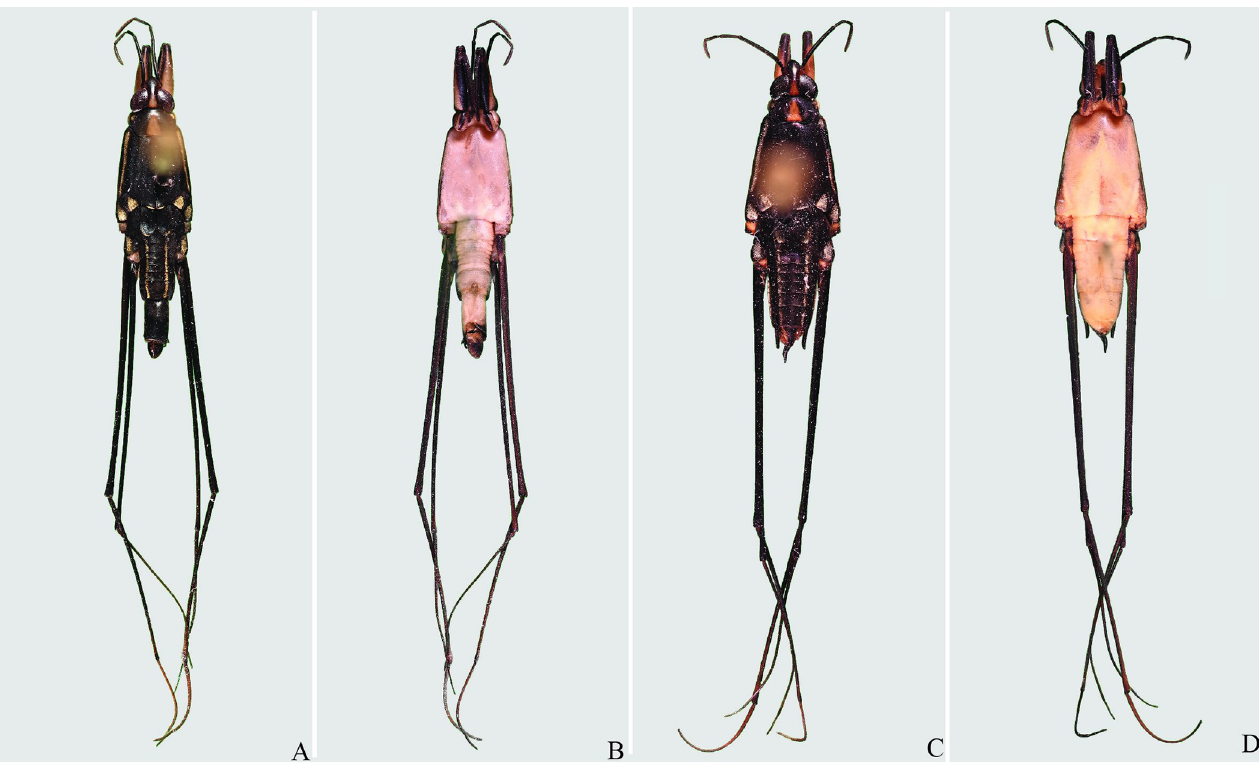
Fig 32. Potamobates tridentatus . (A) Male, dorsal view; (B) male, ventral view; (C) female, dorsal view; (D) female, ventral view.